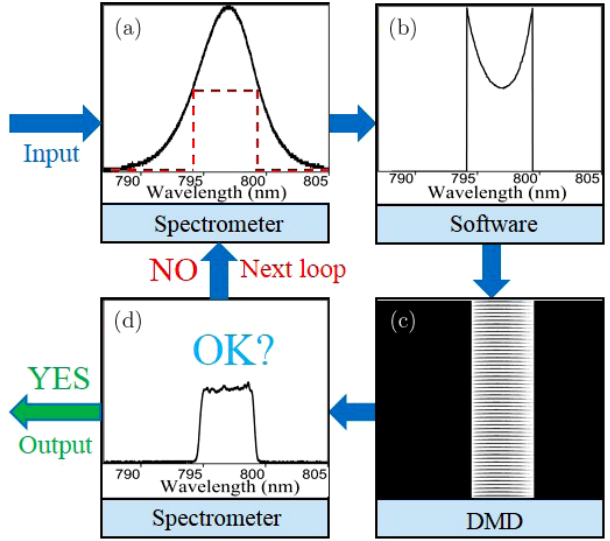
Fig. 3. (Color online) (a) Measured spectrum of an input pulse (black curve) and target spectrum (red curve); (b) shaping function calculated by the computer; (c) patterns for spectrum shaping on the DMD; and (d) shaped spectrum.